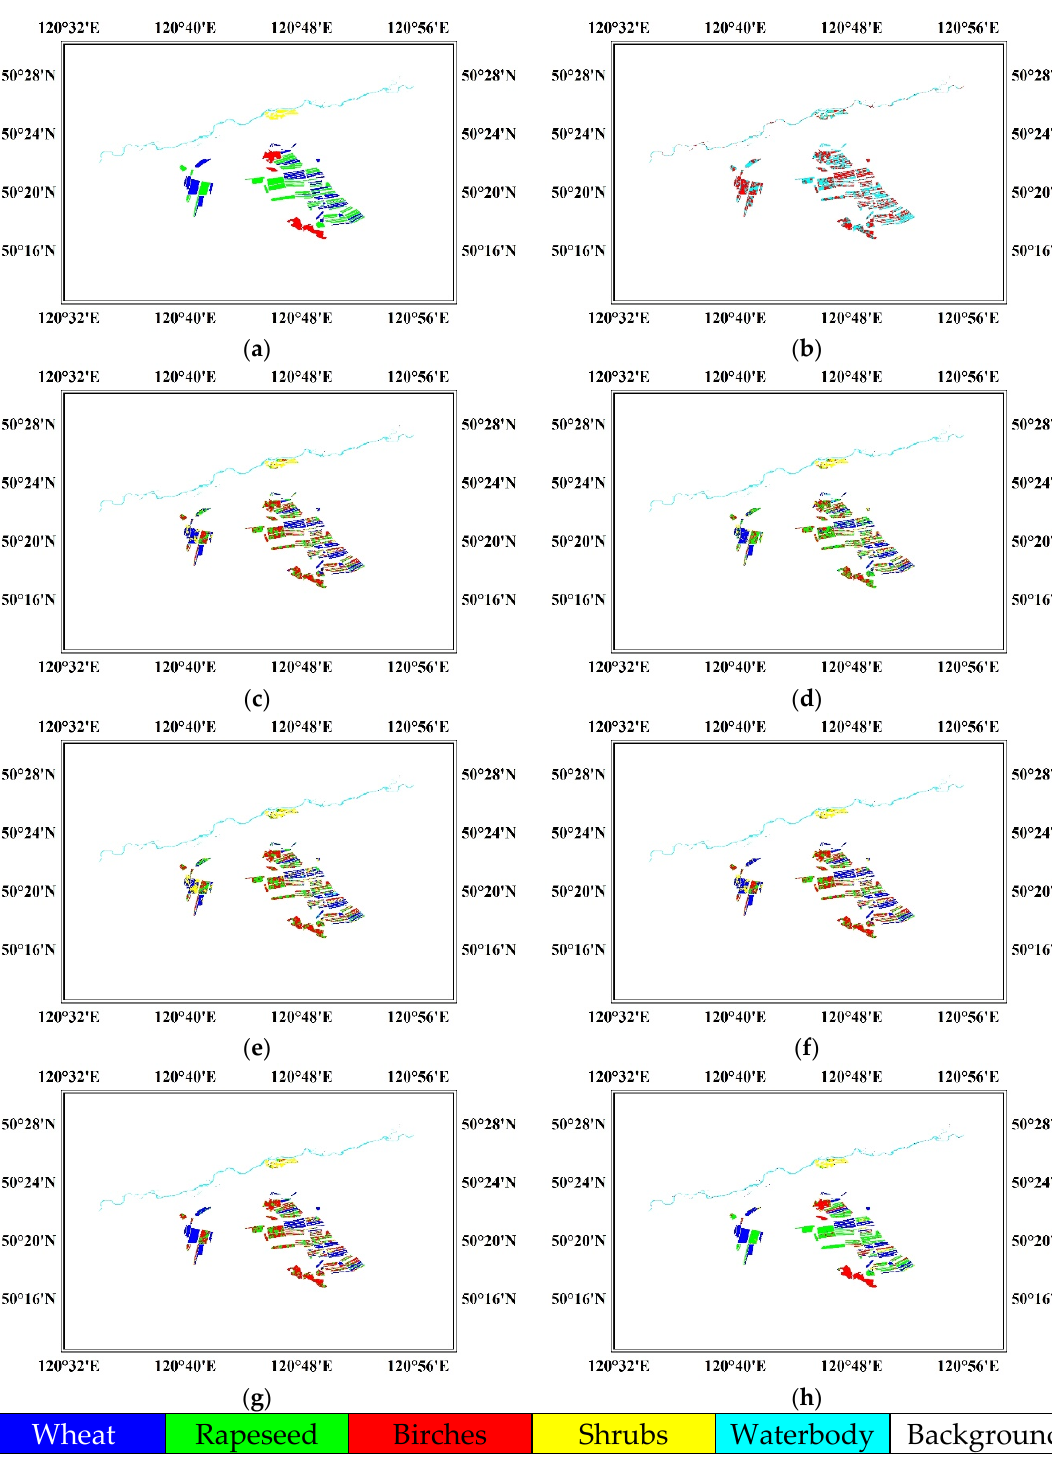
Figure 10. Ground truth map and classification maps in Erguna (SD: A -> TD: C), generated by different methods: ( a ) Ground truth; ( b ) DAC; ( c ) TCA+DAC; ( d ) SSTCA+DAC; ( e ) MIDA+DAC; ( f ) SMIDA+DAC; ( g ) SMbDA+DAC; ( h ) WSMbDA+DAC.